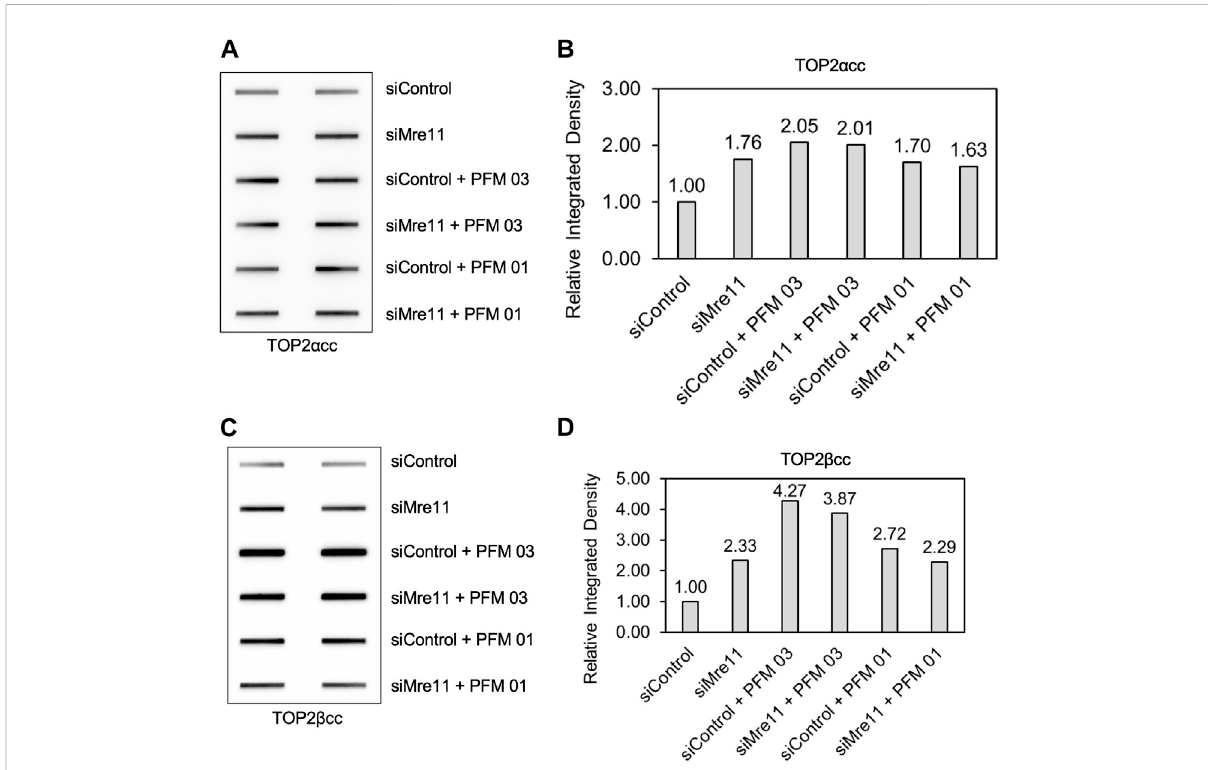
Inhibition of MRE11 endonuclease activity does not change the level of TOP2 covalent complexes when MRE11 is depleted. RH30 cells were transfected with non-targeting siRNA control (siControl) or siRNA targeting MRE11 (siMRE11) as in Figure 1. These cells were then pre-treated with 25 μ M PFM03 where indicated. Etoposide (10 μ M) was added, and incubation was continued for 2 h before ICE assays. (A) Representative ICE assay measuring thelevels ofTOP2 α cc. (B) Densitometric analysis ofallassays comparing relativeintegrated densities ofTOP2 α cc signals. Integrated density of TOP2 α cc signal of each group was normalized to that of siControl cells treated with etoposide alone. Levels of TOP2 α cc for siControl versus siMre11 cells treated with PFM03 were not statistically different. (C) Representative ICE assay measuring the levels of TOP2 β cc. (D) Densitometric analysis of all assays comparing relative integrated densities of TOP2 β cc